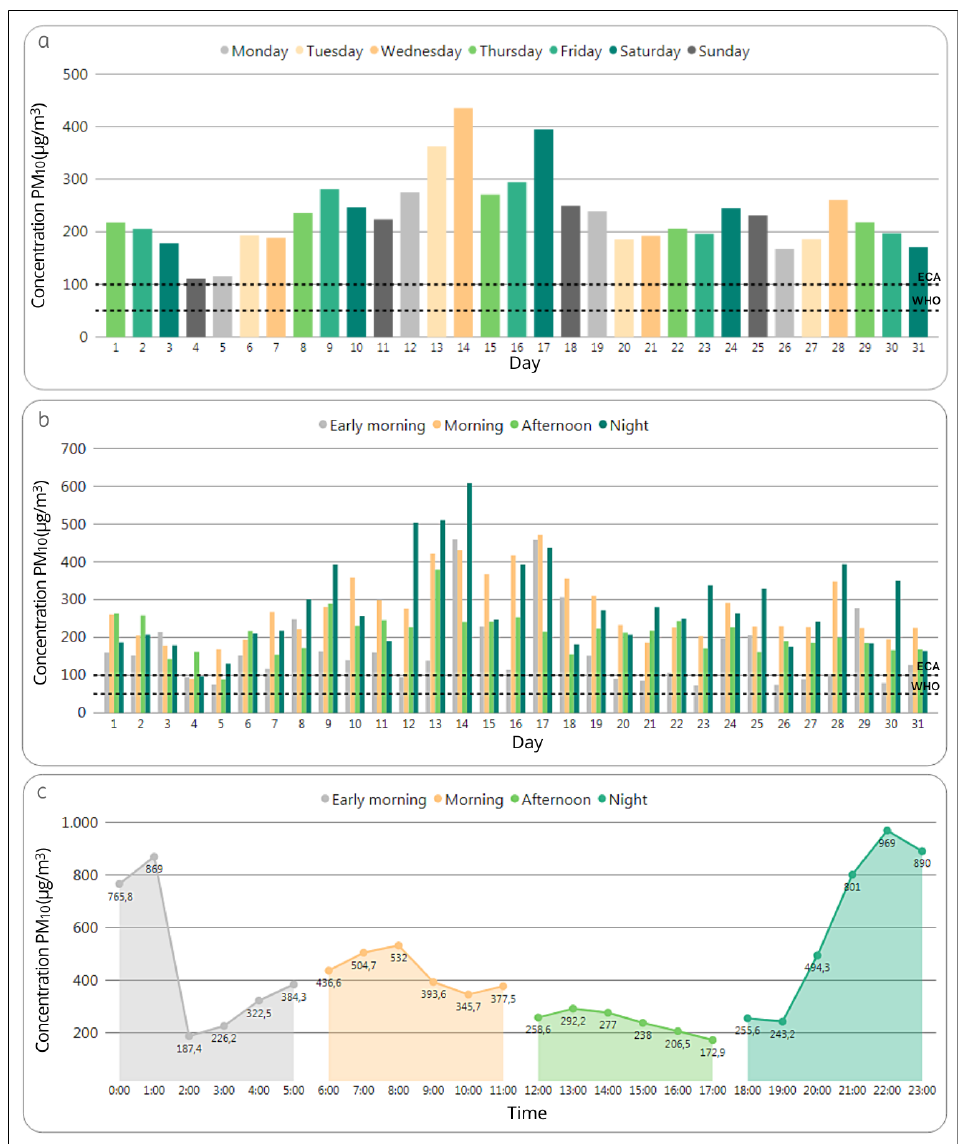
Figure 7. ( a ) Distribution of PM 10 concentration by day in March 2018. ( b ) Distribution of PM 10 concentration by episodes in March 2018. ( c ) Classification of PM 10 concentration by episodes in 14 March